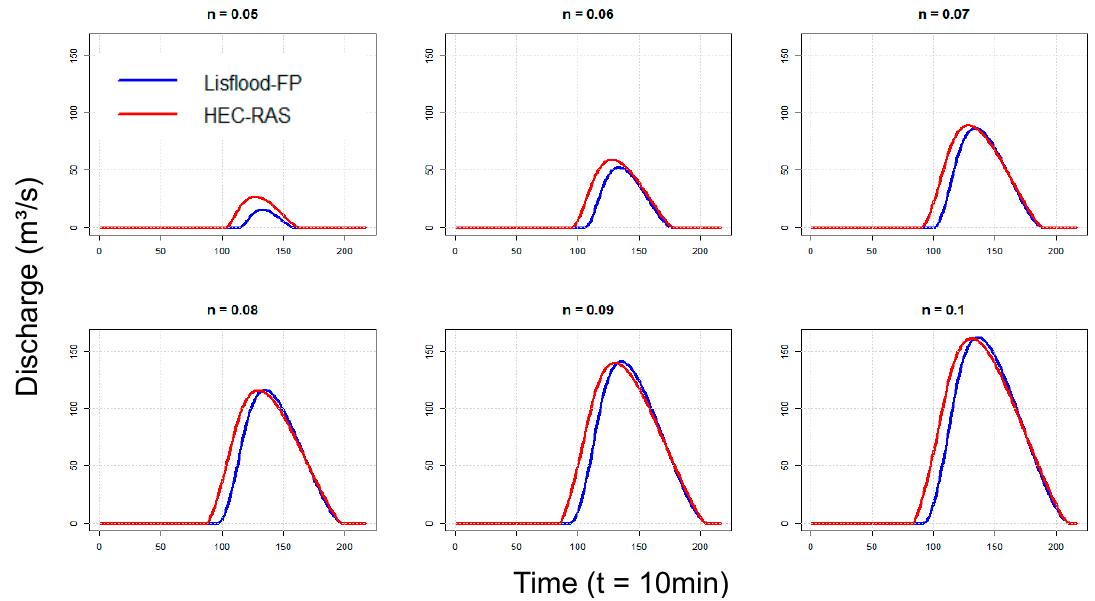
Figure 6. Flow through the breach simulated by HEC-RAS and LISFLOOD-FP with different roughness coefficients n under unsteady boundary conditions.